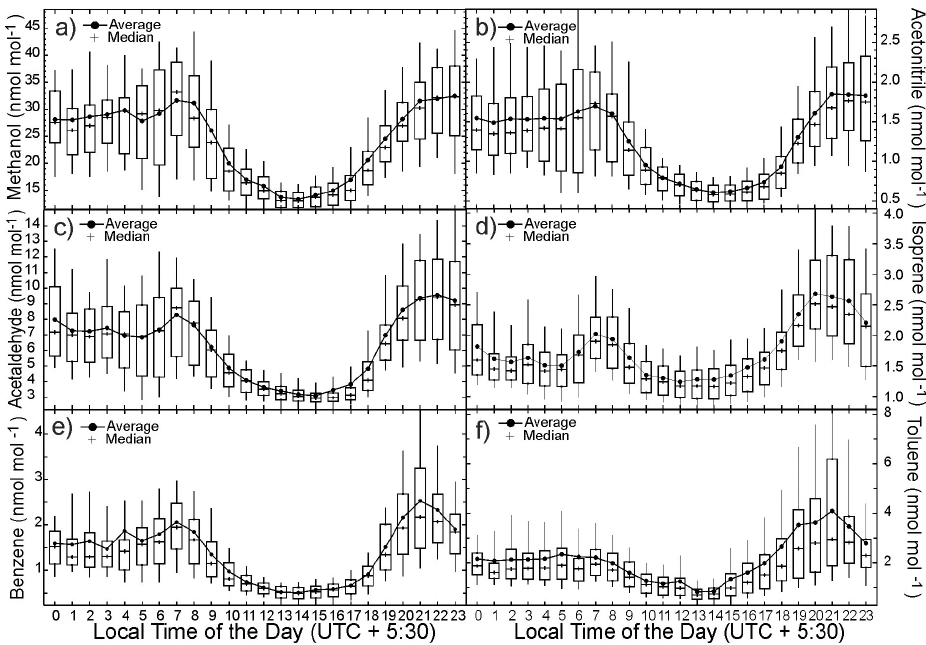
Figure 10. Diel box and whisker plot of (a) methanol, (b) acetonitrile, (c) acetaldehyde, (d) isoprene, (e) benzene and (f) toluene derived from all measurements ( n > 14300 for each species) in May 2012 at the measurement